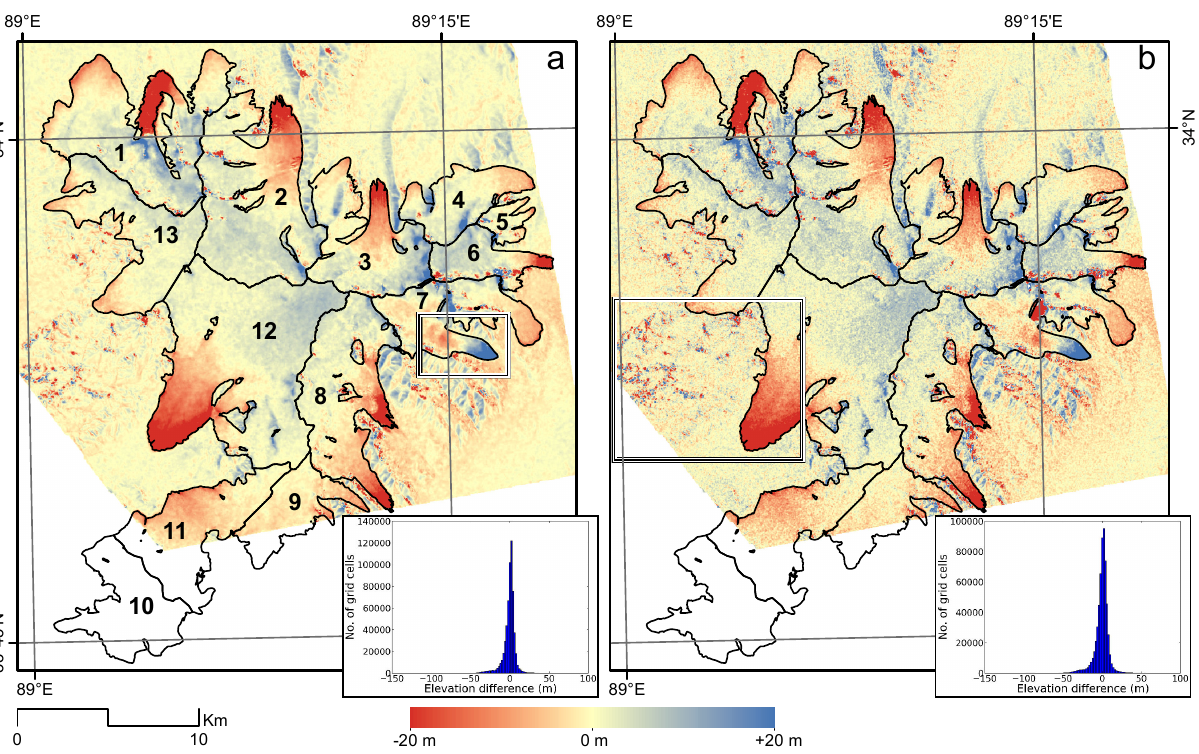
Fig. 5. Elevation changes of the PIC between February 2000 and January 2012. Figure (a) shows the difference map derived by DInSAR while Fig. (b) shows the difference map derived from absolute heights. The glacier outline is based on the geometric union of the 2000 and 2012 Landsat derived glacier extent. Histograms show the on-glacier elevation differences. Table 2. Mean surface elevation changes estimated by DInSAR and from DEM differencing are listed next to the area changes and the annual mass budgets for the single glaciers shown in Figs. 1 and 5a. The geometric union of the 2000 glacier area ( A 2000 ) and the 2012 glacier area ( A 2012 ) is also shown. The error of the surface elevation changes is estimated as ± 2.40m for the DInSAR approach and as ± 3.71m for the DEM differencing, which also applies for the listed single glaciers.